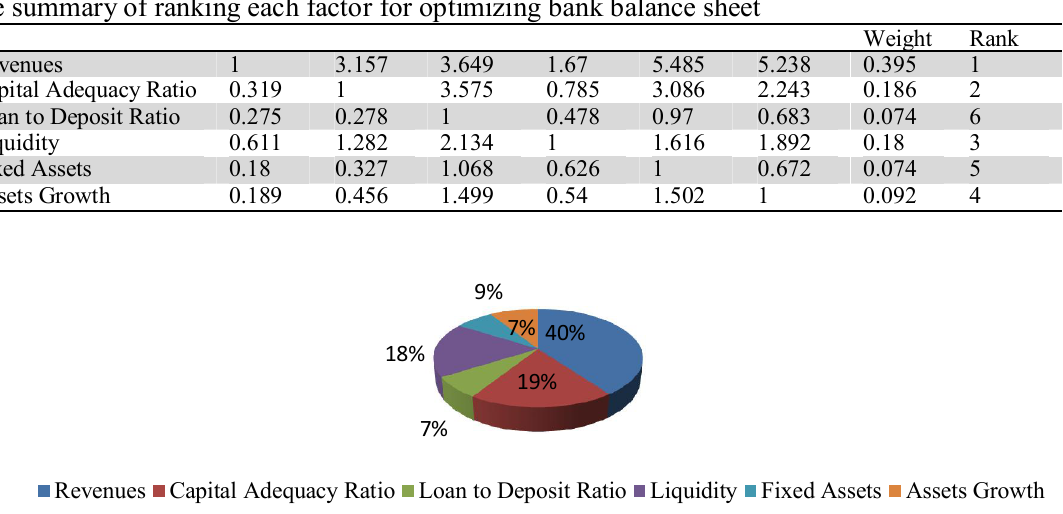
Fig. 2. Final Weight of Each